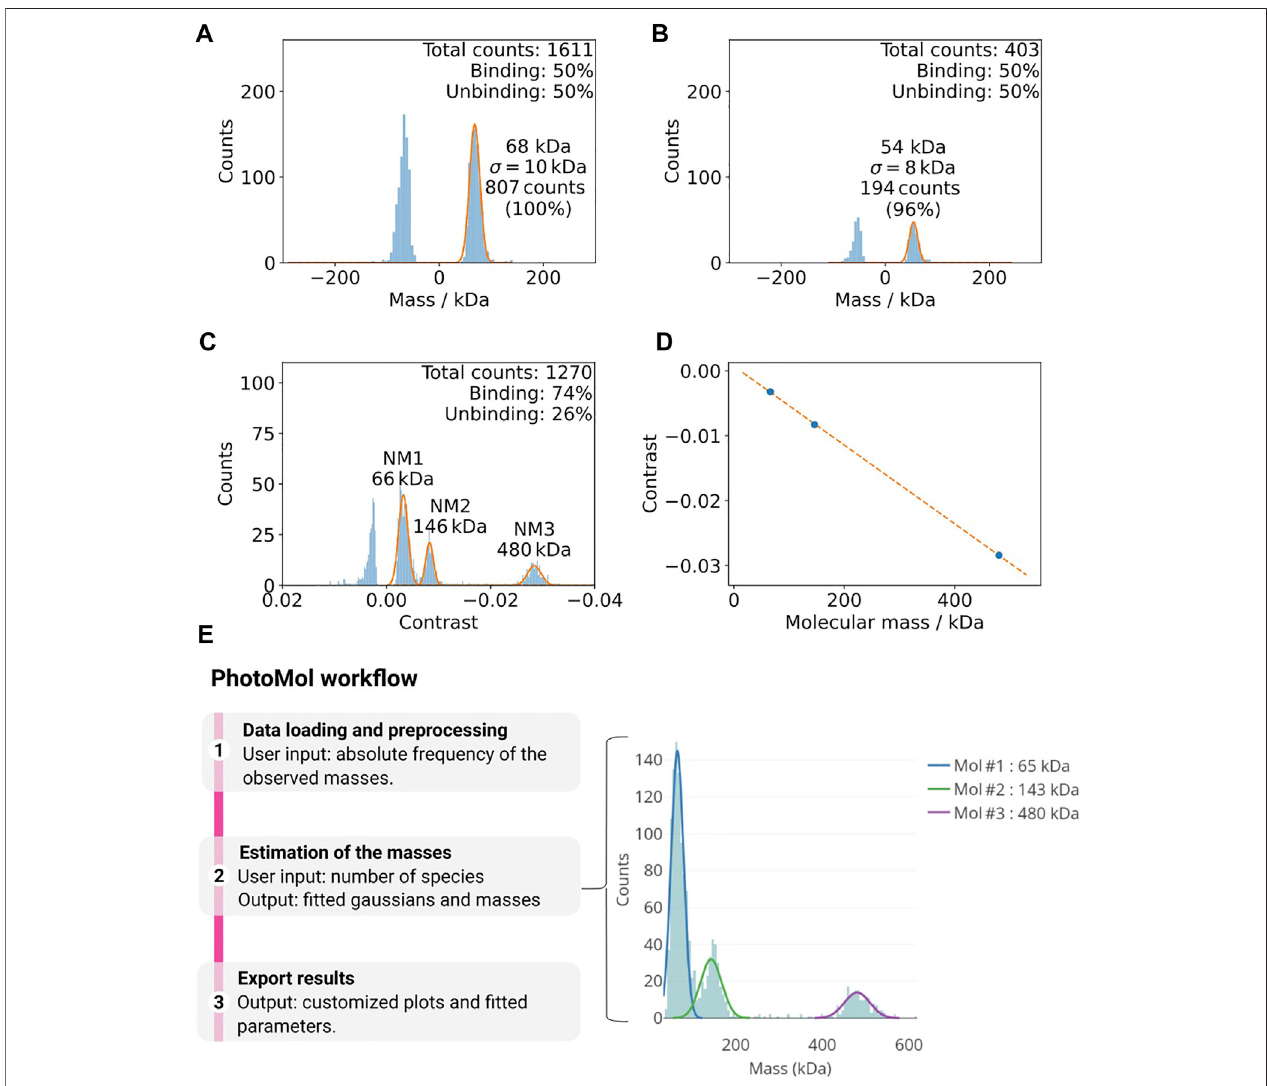
FIGURE 3 | (A,B) Example of how buffer impurities can negatively affect mass photometry measurements (Tris-HCl 100 mM, pH 8.5, 100 mM NaCl, 1 mM DTT). (A) Thevacuum fi lteredbuffer on theleft shows aconsiderable amount ofcounts at ca.68 kDa. (B) An additional fi lterstep(right)drasticallydecreases thisbackground. (C,D) Calibrationofmassphotometer. (C) Histogramofthemassdistributionsusedforthecalibrationofthemassphotometerusing thenativemarkerinPBSbuffer(pH 7.4).TheGaussian fi ttingsforthedifferentpopulationsareshowninorange. (D) Thecontrastvaluesfrom (A) andtheknownmassesofthecalibrationstandardsare usedforacalibrationline(maximumerrorhere0.3%). (E) ThePhotoMolpipelineconsistsofthreesteps.First,theuserloadsaninput fi lethatcontainsthefrequencyofthe observed masses (or contrasts). Pre-processing is fi rst performed by selecting a bin width and a window range to build the histogram. Second, the user de fi nes the number of Gaussians (species) present in the distribution and a truncated multi-Gaussian fi t is executed. Finally, publication-grade fi gures can be downloaded together with information about the fi tted parameters.